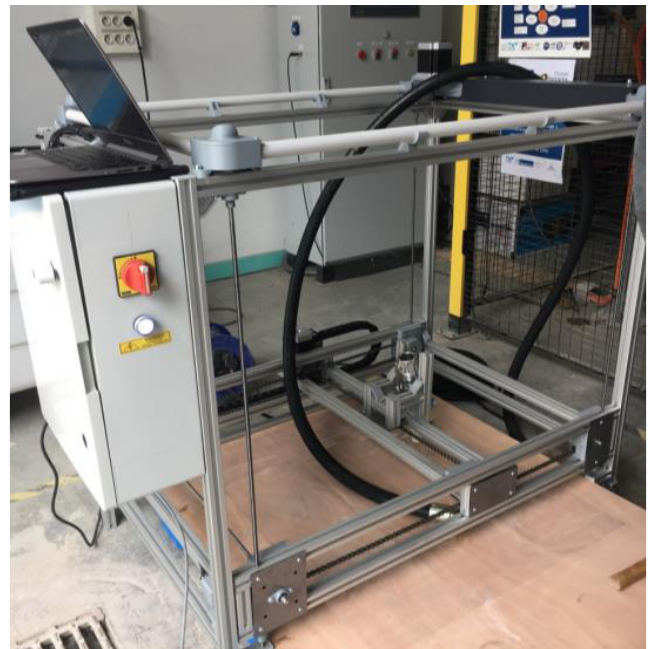
Figure 3. The 3-axis gantry printer used in this study.